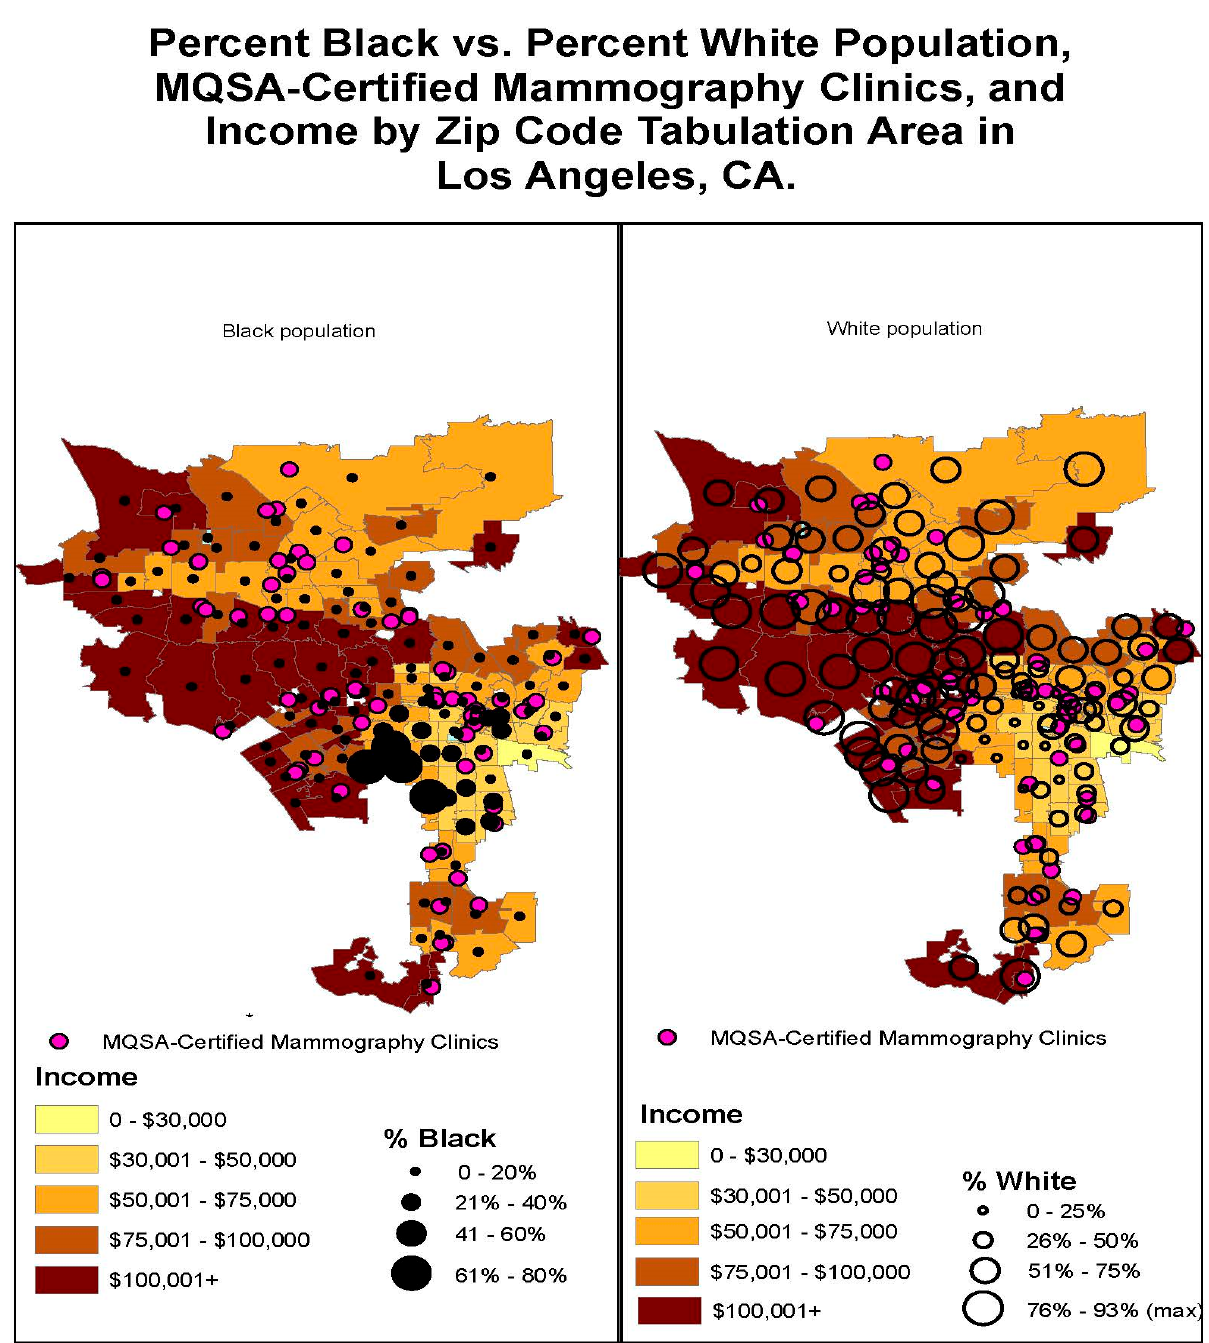
Figure A4. Percent Black vs. Percent White Population, MQSA-Certified Mammography Clinics, and Income by ZIP Code Tabulation Area in Los Angeles, CA.